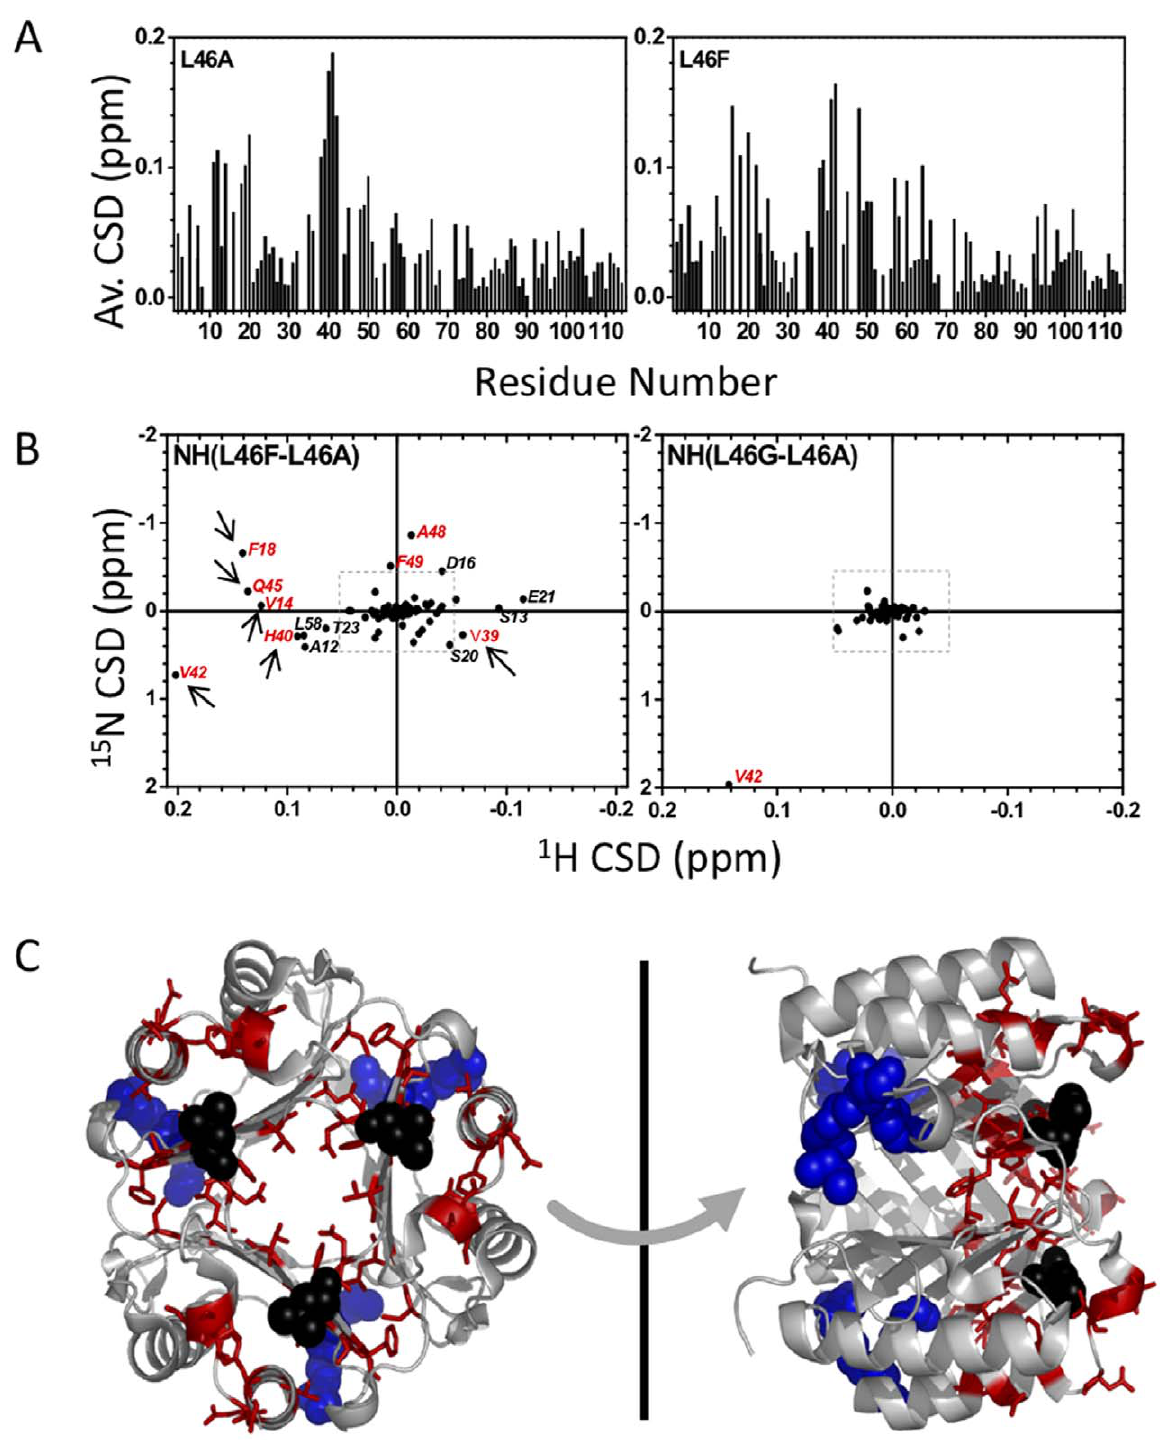
Figure 4. NMR chemical shift perturbations by Leu46 mutants reveal higher fluctuation of the Leu46 pocket. (A) Normalized changes in 1 H, 1 5N chemical shifts of L46A and L46F MIF compared to the wild-type protein from wild-type huMIF. Normalized shift changes are calculated according to ! ( D H2 + ( D N/5)2 ). (B) Two-dimensional representation of chemical shift deviations of L46F and L46G MIF from those of the L46A mutant. The gray square is drawn at + / 2 0.2 ppm in 15 N, + / 2 0.02 ppm in the 1 H dimension and separates very small from larger chemical shift changes. Arrows indicate residues belonging to the hydrophobic pocket. (C) Residues with chemical shift deviations larger than + / 2 0.2 ppm in 15 N, + / 2 0.02 ppm in the 1 H dimension in L46F and L46A MIF (relative to wt MIF) are mapped onto the MIF crystal structure. Leu46 is shown as black sphere, catalytic core residues (1, 32, 64) as blue sticks, residues with strong chemical shift changes are colored in red.